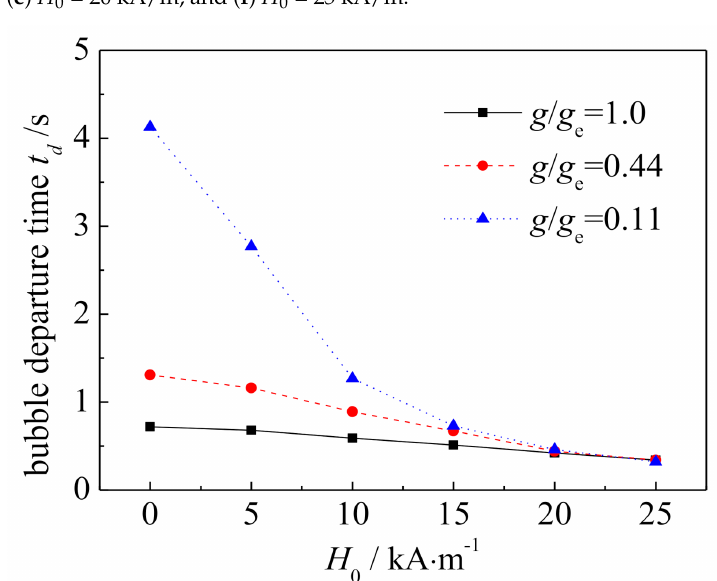
Figure 9. Variation of the bubble departure time with the magnetic field intensity at different gravity